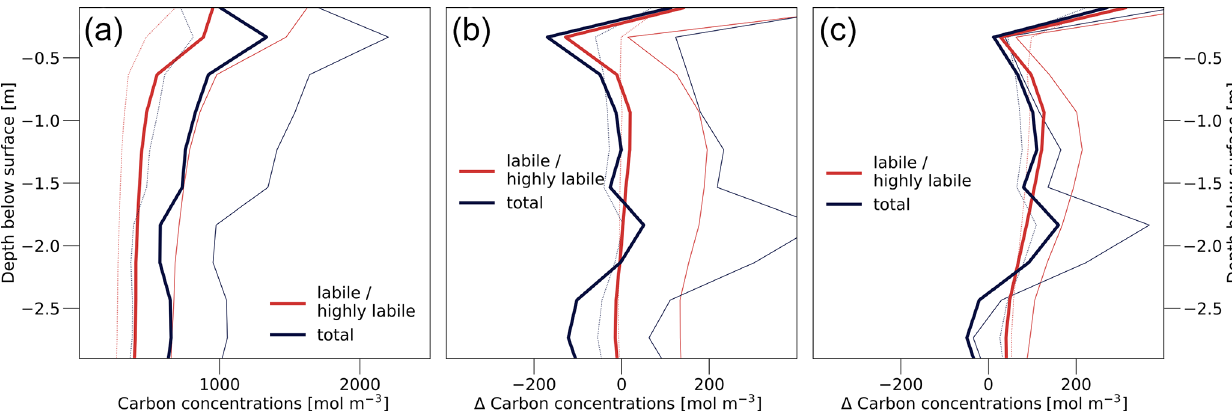
Figure 11. Soil carbon profiles in seasonally inundated areas. (a) Carbon concentration as a function of soil depth in the year 2000 (1990– 2010 average). Red lines show the concentration of labile and highly labile organic matter, while blue lines represent the total carbon concentration. Thick solid lines show the ensemble mean, while dotted lines indicate the ensemble minimum, and thin solid lines the ensemble maximum. (b) Change in soil carbon concentrations between the forcing peak in the year 2100 (2090–2110 average) and the year 2000 (1990– 2010 average). (c) Same as (b) but showing the differences between the years 2200 – when the forcing is fully reversed after a GHG peak in the year 2100 – and 2000. All panels show the average over permafrost-affected grid boxes, weighted by their (annual mean) wetland